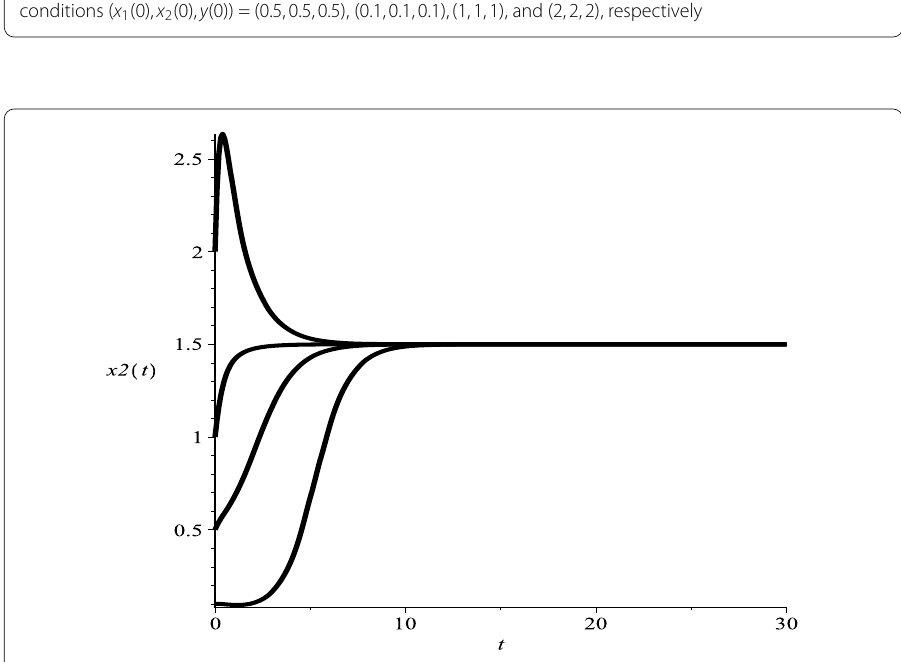
Figure 6 Dynamic behaviors of the second component x 2 ( t ) of system (4.1), here we take d = 2 and the initial conditions (